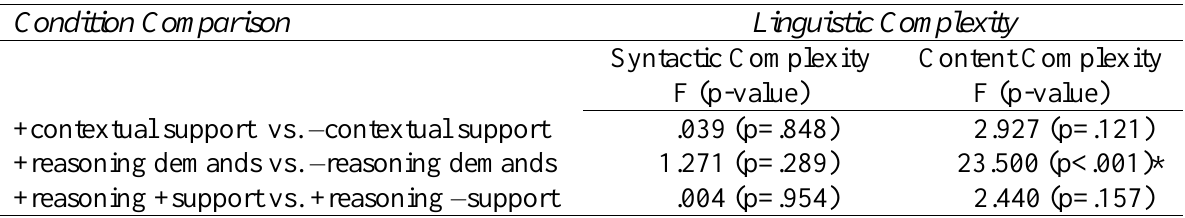
Repeated Measures Analysis for Experimental Group